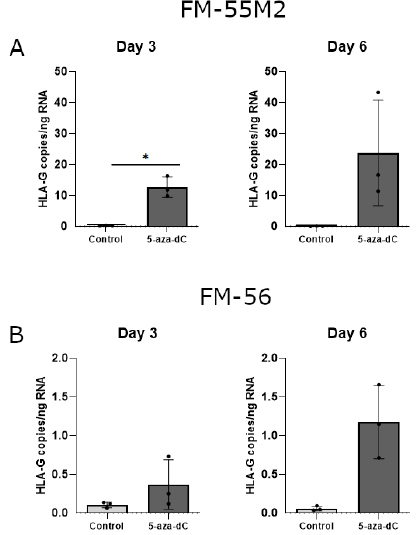
Figure 7. HLA-G mRNA expression in stimulated malignant melanoma cell lines. The e ff ect of 5-aza-dC on the transcriptional level of HLA-G was determined by ddPCR and presented as number of HLA-G copies per amount of RNA. ( A ) FM-55M2 cells treated with 100 µ M 5-aza-dC for three and six days. ( B ) FM-56 cells treated with 100 µ M 5-aza-dC for three and six days. Shown are mean ± SD, each dot represents one sample. * p < 0.05 (Student’s unpaired t -test with Welch’s